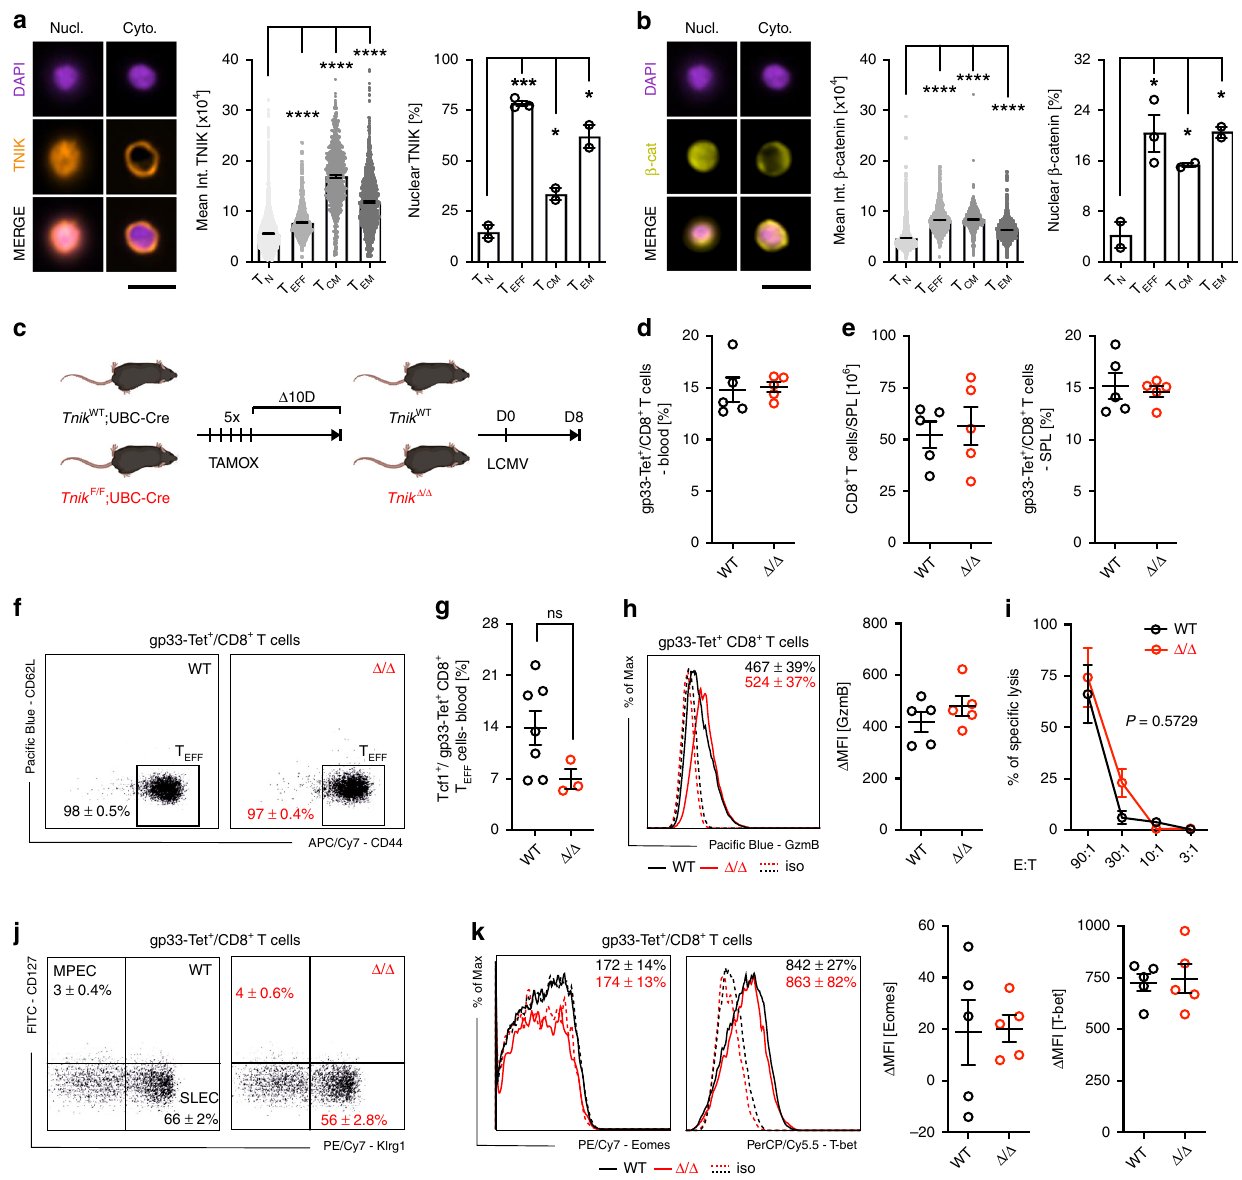
Fig. 1 TNIK is dispensable for effector T-cell response. a, b Naive (T N ) or activated AdTf p14 T cells isolated from the spleen 6 or 40 days p.i. with 10 4 pfu LCMV-WE were FACS-sorted, stained for TNIK and β -catenin, and analyzed by ImageStream X (day 6 p.i.: T EFF , day 40 p.i.: T CM , T EM ). Single-cell images: nuclear (DAPI) stain, nuclear (Nucl.) vs cytoplasmatic (Cyto.) distribution of TNIK or β -catenin, and overlay (merge). Dotplots: Mean TNIK or β -catenin intensity of T N ( n = 8638), T EFF ( n = 1252), T CM ( n = 630) , T EM ( n = 1308) and % nuclear localization of n = 2 – 3 sample replicates per cell subset. Scale bar 10 μ m. c Tamoxifen-induced systemic deletion: Tnik F/F ; Ubc-Cre ( Tnik Δ / Δ ) and control-treated Tnik WT/WT ; Ubc-Cre ( Tnik WT ) mice were infected i.v. with 200 pfu LCMV-WE. d – j Day 8 p.i.: d frequency of gp33-Tet + cells per CD8 + T cells in blood, e CD8 + T-cell numbers in the spleen and frequency of gp33- Tet + cells per CD8 + T cells in the spleen, f effector phenotype (T EFF , CD44 + CD62L − ) of gp33-Tet + CD8 + T cells, g frequency of Tcf1 exrepssing T EFF cells, h histogram and Δ MFI of granzyme B expression in gp33-Tet + CD8 + T cell, i lysis of gp33 peptide pulsed MC57 target cells by Tnik WT and Tnik Δ / Δ CD8 + T cells at different effector/target ratios (E:T), j frequency of memory precursor effector cells (MPECs; CD127 + KLRG1 − ) and short-lived effector cells (SLECs; CD127 − KLRG1 + ) within gp33-Tet + CD8 + T cells, k histograms and Δ MFI of intracellular Eomes/T-bet staining in gp33-Tet + CD8 + T cells. Depicted: Tnik WT (black lines/circles), Tnik Δ / Δ (red lines/circles), isotype controls (iso; dashed lines). d – f , h – k Data are representative for one out of two ( n = 5) independent experiments. Data are displayed as means ± SEM. Statistics: two-tailed Student's t test, nonsigni fi cant P > 0.05, * P < 0.05, *** P < 0.001, **** P < 0.0001. Also see Supplementary Figs. 1 and 2. Source data are provided as a Source Data fi